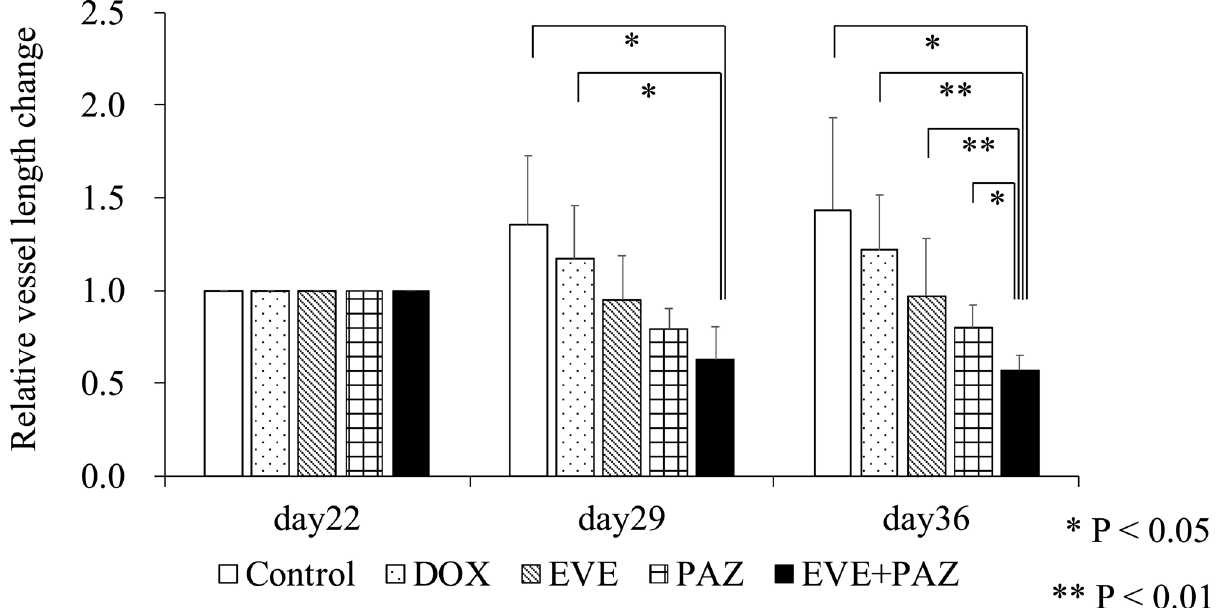
Figure 8. Drug efficacy in the in vivo Gelfoam angiogenesis assay. Bar graphs show the vessel length ratio on the day of measurement relative to day 22, which was the day of OS-PDC implantation into the Gelfoam previously inplanted in the mouse. Bar graphs express the average vessel length ratio and error bars show ± standard deviation. Statistical analysis was performed using Steel–Dwass test. *P < 0.05. **P <